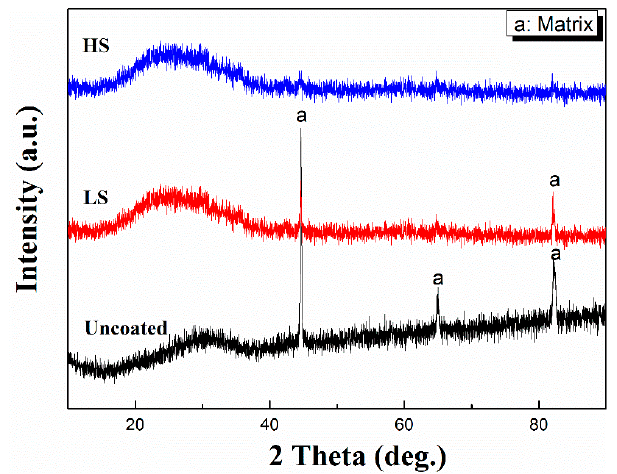
Figure 4. XRD patterns of the uncoated, LS and HS samples after corrosion in the 0.5 M HCl solution at 30 °C for three days.